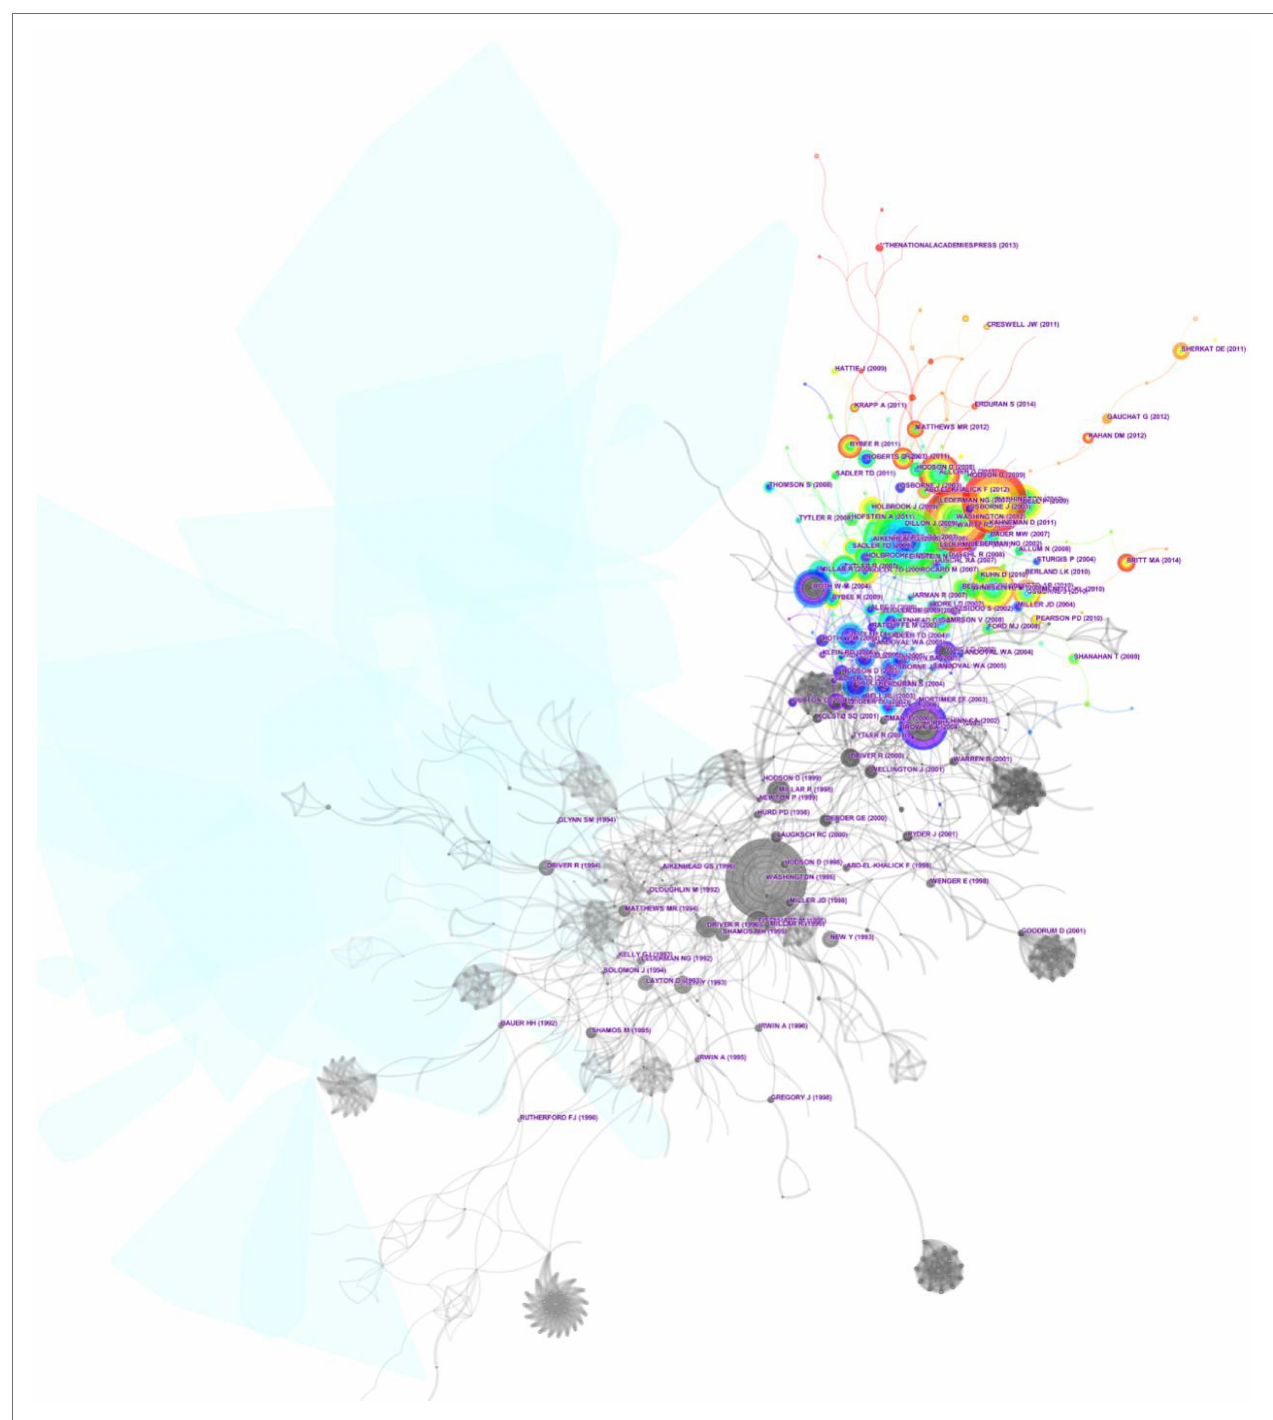
FIGURE 4 | Highly co-cited articles in the intellectual field of scientific literacy between the years 1980 and